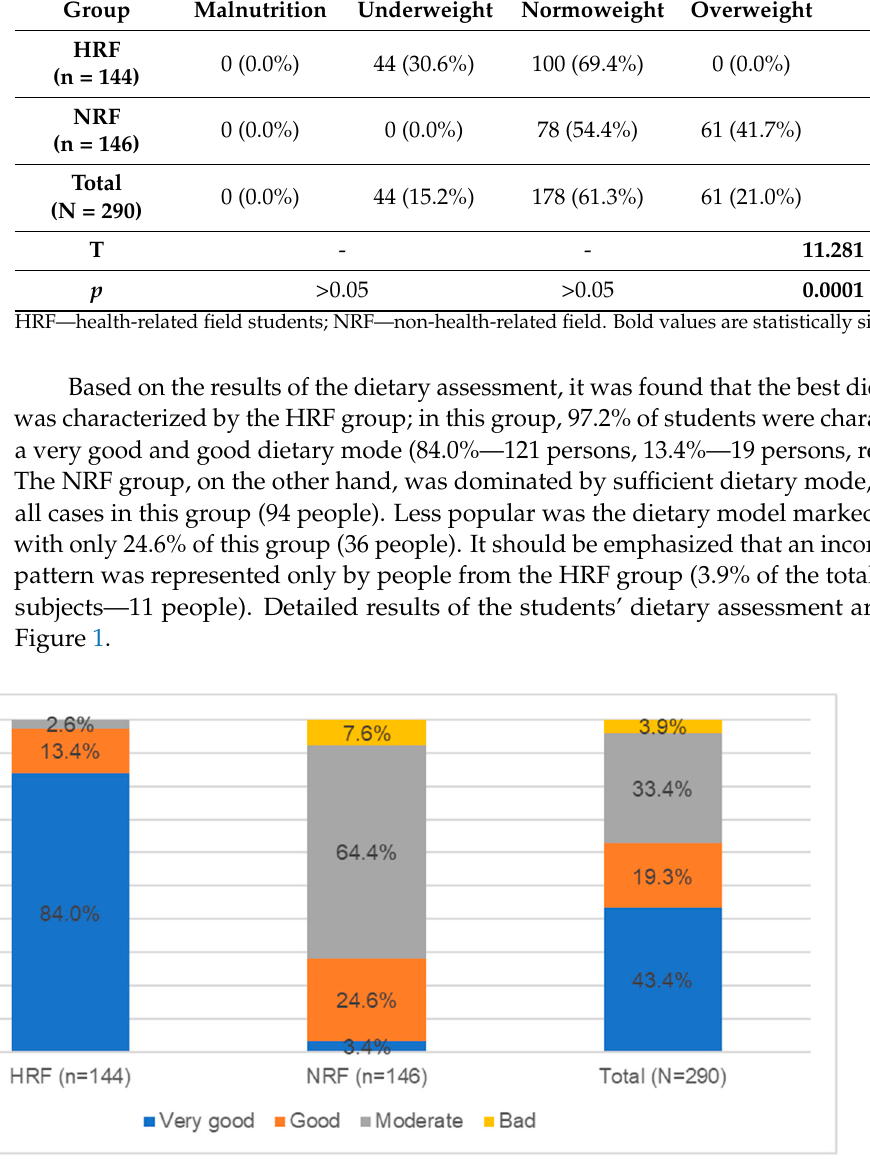
Figure 1. Students’ dietary assessment (N = 290): HRF—health-related field students; NRF—non- health-related field.